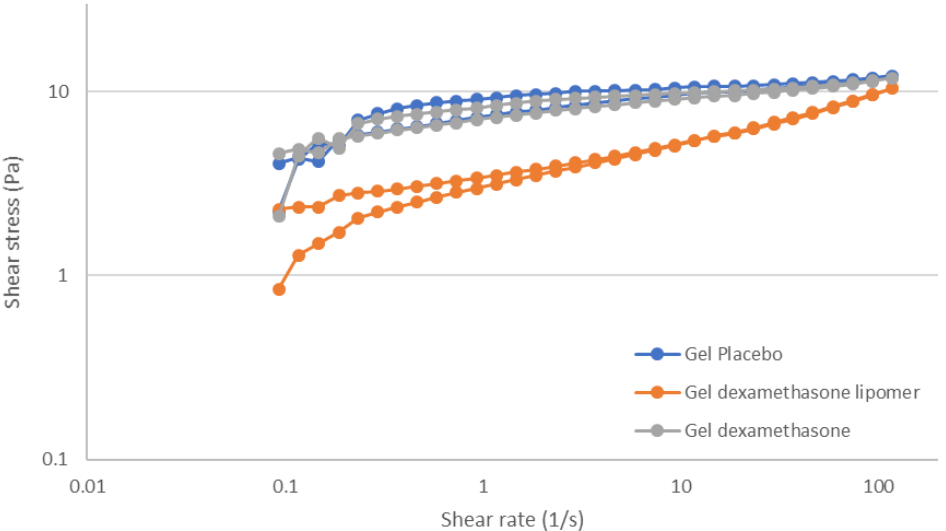
Figure 5. Shear stress vs. shear rate curves of the hydrogel formulations. Table 5. Rheological model fitting of hydrogel placebo, dexamethasone hydrogel, and freeze-dried dexamethasone lipomers hydrogel.